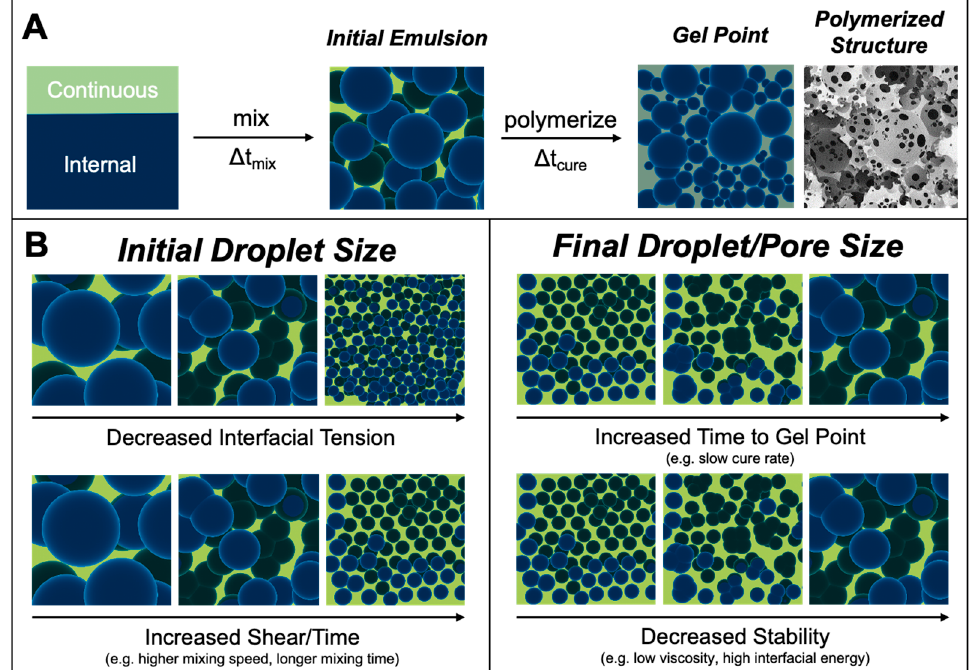
Figure 1. Generation of polyHIPE pore architecture based on emulsion templating parameters. ( A ) Schematic of emulsion fabrication: mixing of the two phases (duration of mixing is Δ t mix = Δ t Mf − Δ t Mi , M f = end of mixing and M i = beginning of mixing), emulsion at gel point (time to gel point is Δ t cure = Δ t Mf − Δ t gel , t gel = gel point), and resulting architecture after crosslinking. ( B ) Overview of thermodynamic and polymerization parameters that affect polyHIPE architecture.